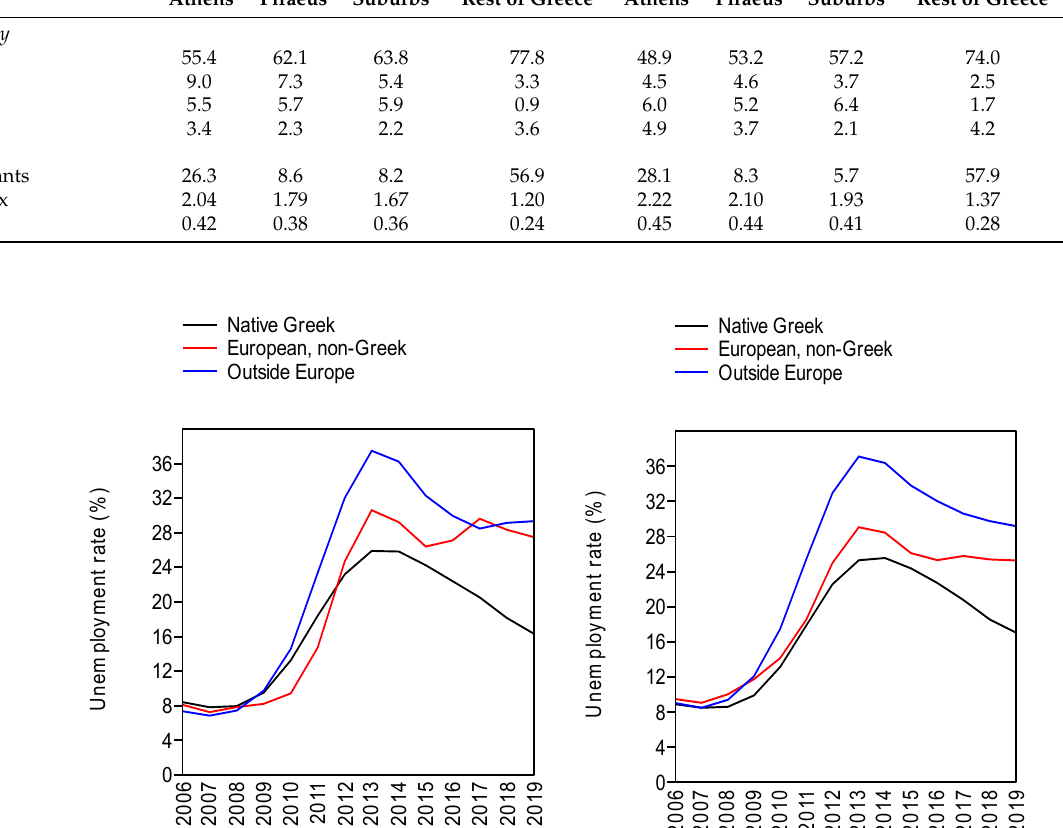
Figure 6. Unemployment rate (%) over time (2006–2019) in Attica ( left ) and Greece ( right ) as a whole by citizenship (source: our elaboration on OECD regional statistics).